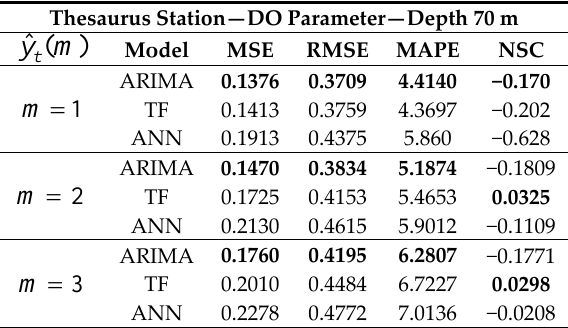
Table 4. Statistical parameters for comparison of observed and predicted values using ARIMA, TF and ANN models and m = 1, 2 and 3 (70 m